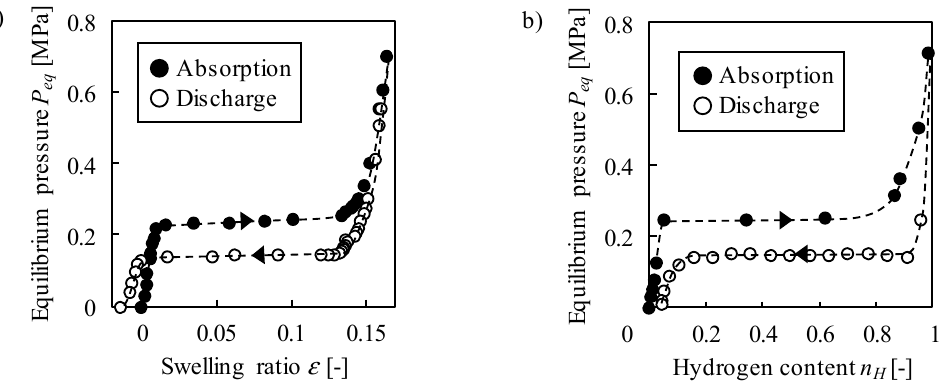
Figure 1. Variation of ( a ) swelling ratio and ( b ) hydrogen content with equilibrium pressure.